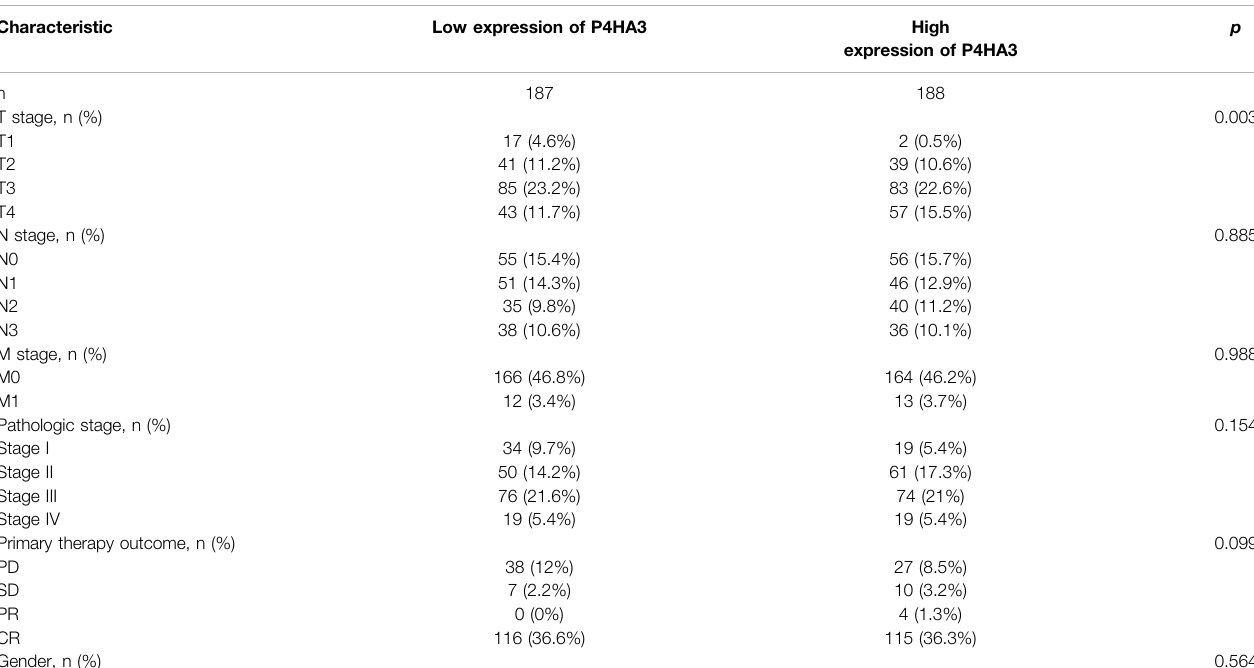
TABLE 2 | Clinical characteristics of the GC patients based on TCGA.